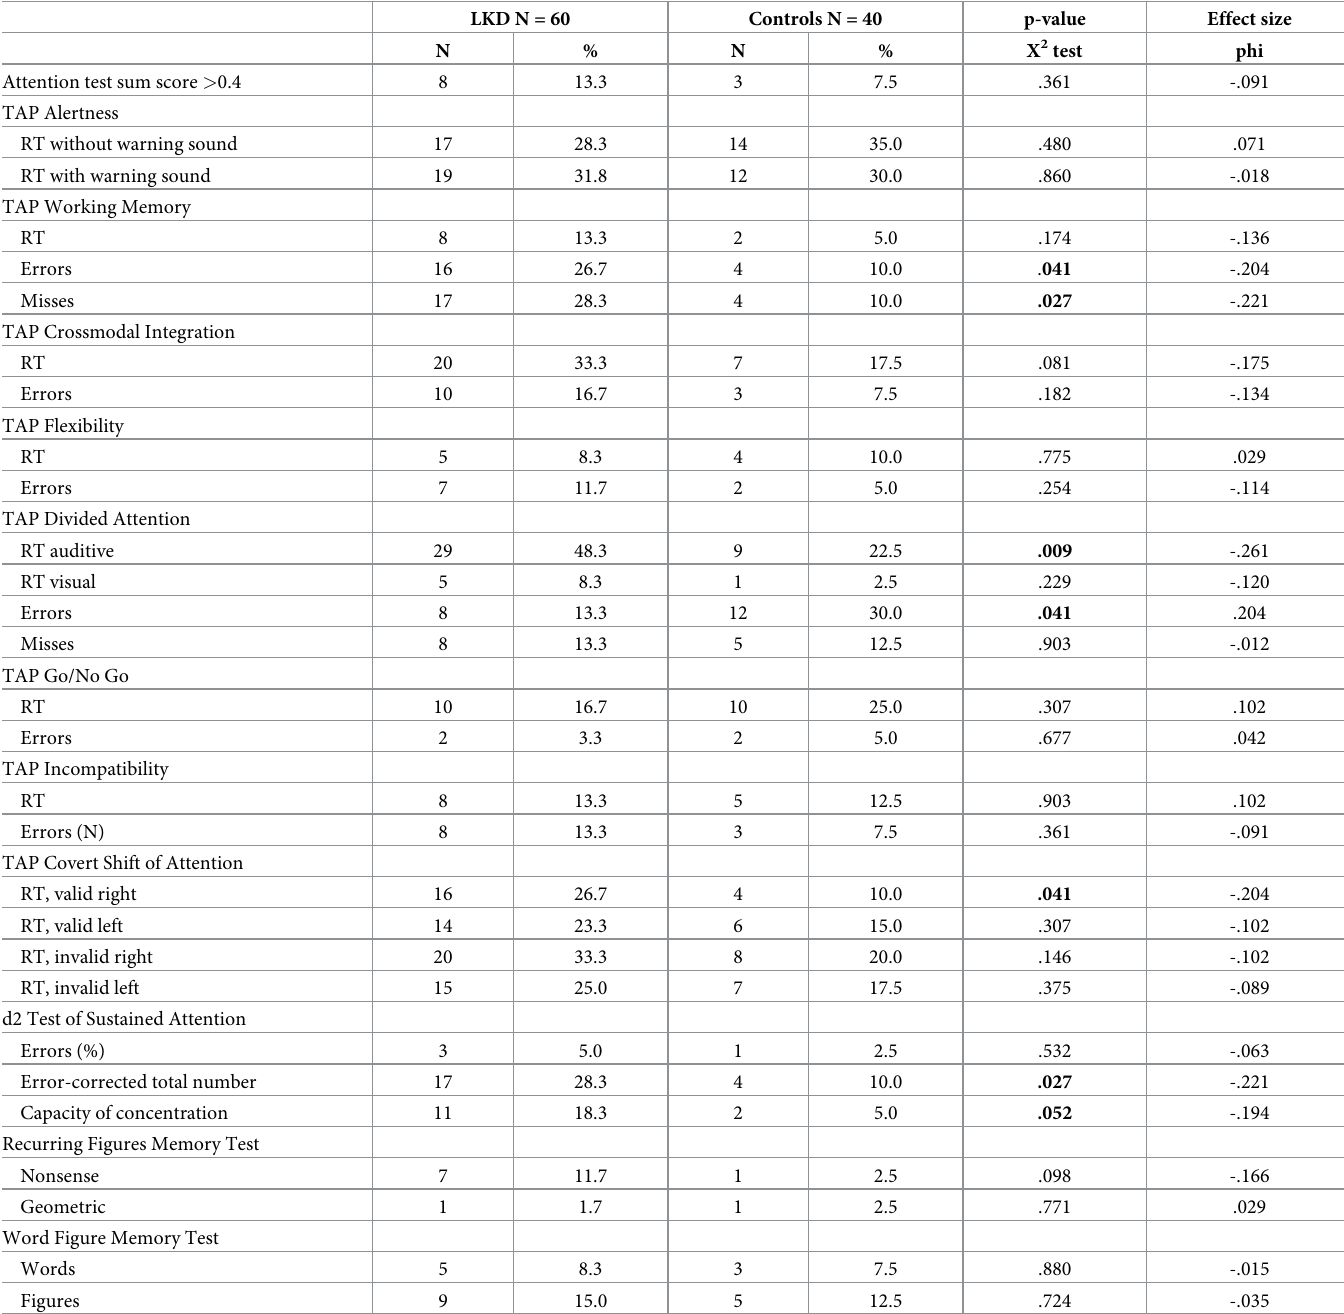
Table 3. Number and percentage of LKD and controls with abnormal test